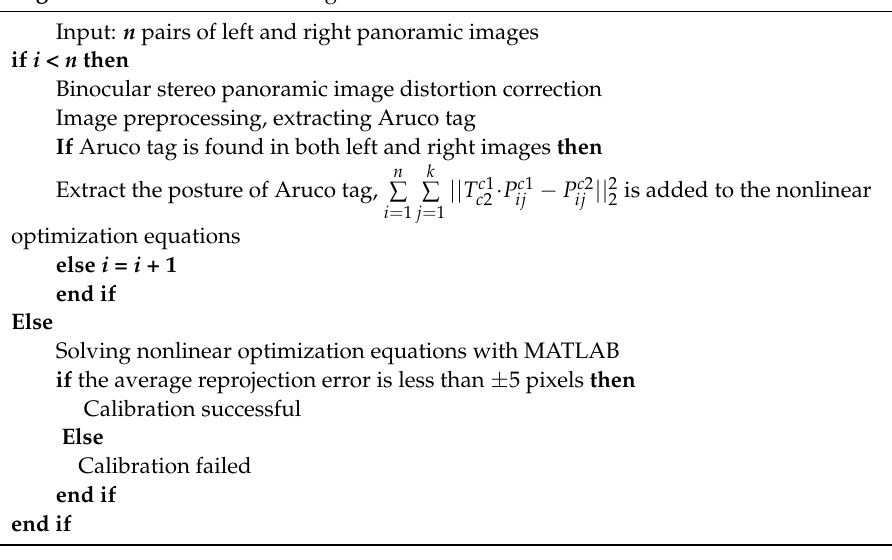
Algorithm 1 Aruco estimates tag